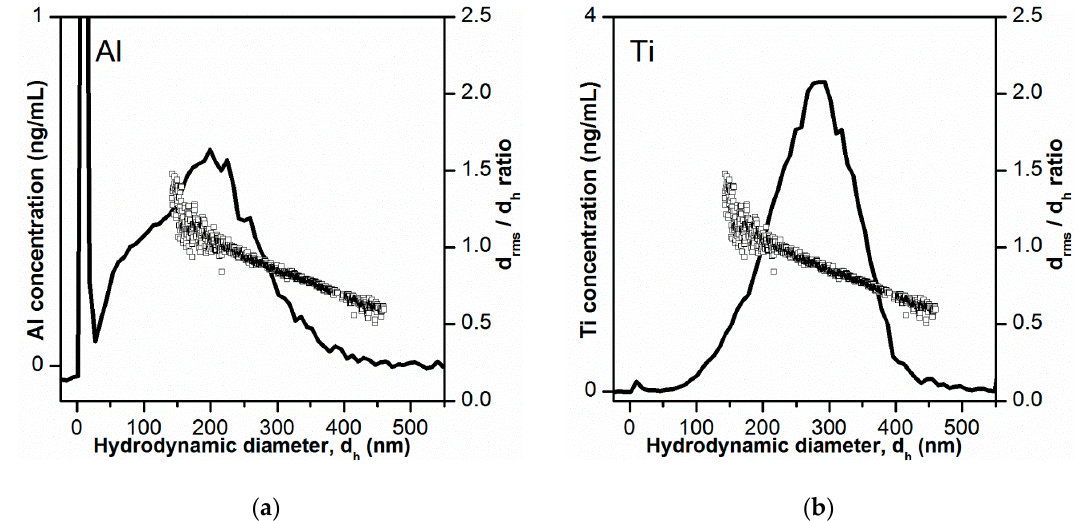
Figure 4. Mass-based particle size distribution (PSD) obtained by AF4-ICP-MS for Al- and Ti-containing particles in toothpaste (black lines in ( a , b ), respectively)). The AF4-ICP-MS retention times were converted to hydrodynamic diameters after AF4 channel calibration with polystyrene size standards. The ratios between rms diameters and hydrodynamic diameters values (d rms /d h ) are shown as white squares.